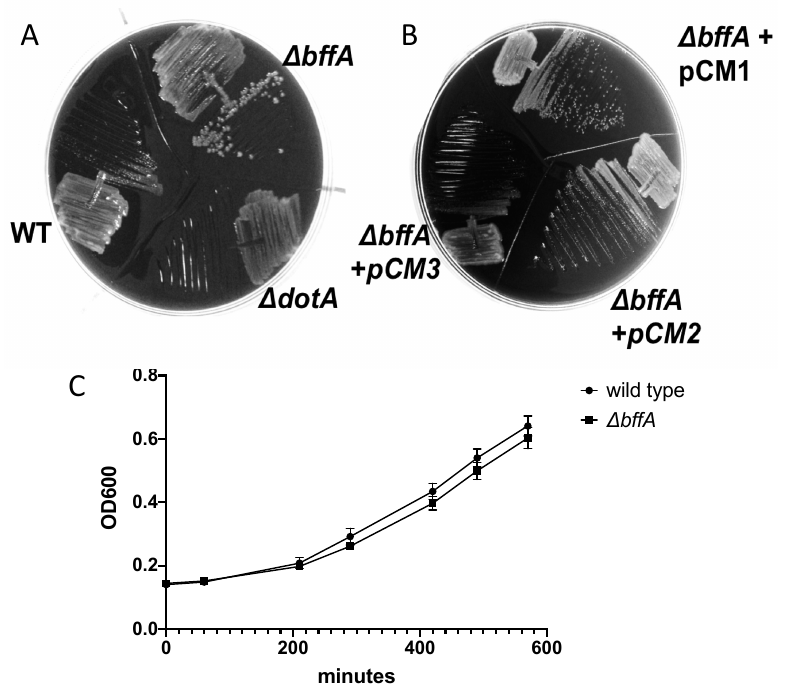
Figure 1. ∆ bffA forms single colonies in two days compared to wild-type and ∆ bffA +pBffA (pCM2) and shows no difference in planktonic growth compared to wild-type. ( A ) Wild-type, ∆ bffA, and Δ dotA strains after two days of growth at 37 °C on CYE agar. ( B ) Δ bffA was also grown with the addition of empty vector (pCM1), pBffA (pCM2), or pBffA (1-366) (pCM3). Both plates were incubated in the same incubator simultaneously, and all strains are in the CR39 genetic background. The image is of a representative experiment. ( C ) Broth growth curves performed with wild-type and Δ bffA strains of the CR39 background display no difference in growth kinetics by the Δ bffA strain. 10 h growth curve. The graph is an average of six replicates.